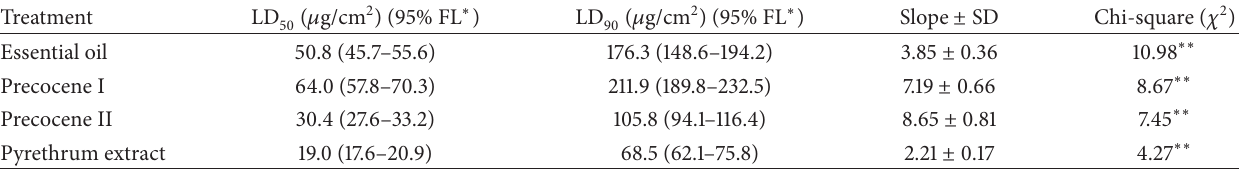
Table 3: Contact toxicity of Ageratum houstonianum essential oil and its isolated compounds against Liposcelis bostrychophila .